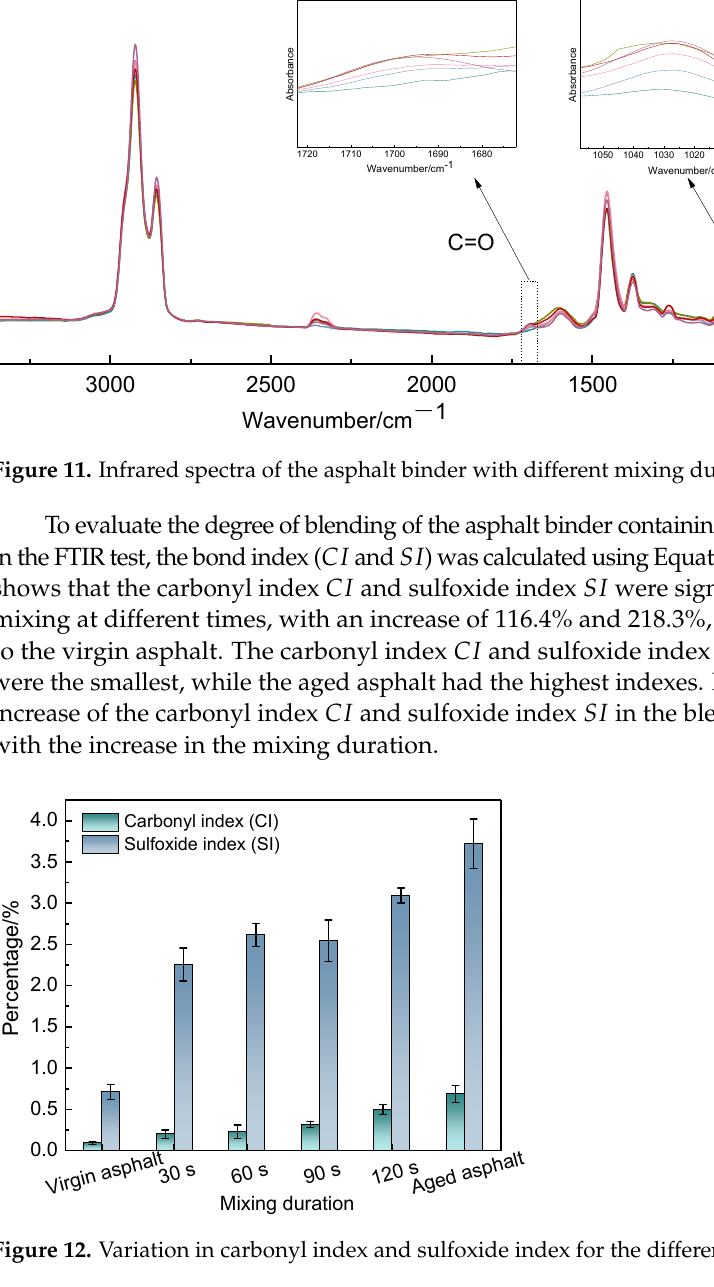
Figure 12. Variation in carbonyl index and sulfoxide index for the different asphalts.